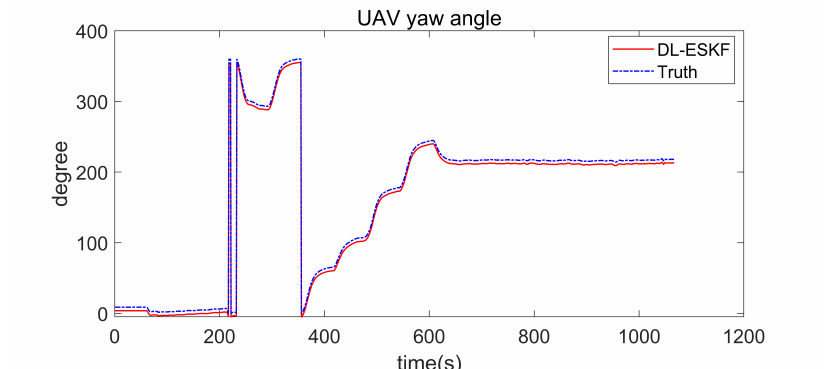
Figure 23. Autonomous flight yaw